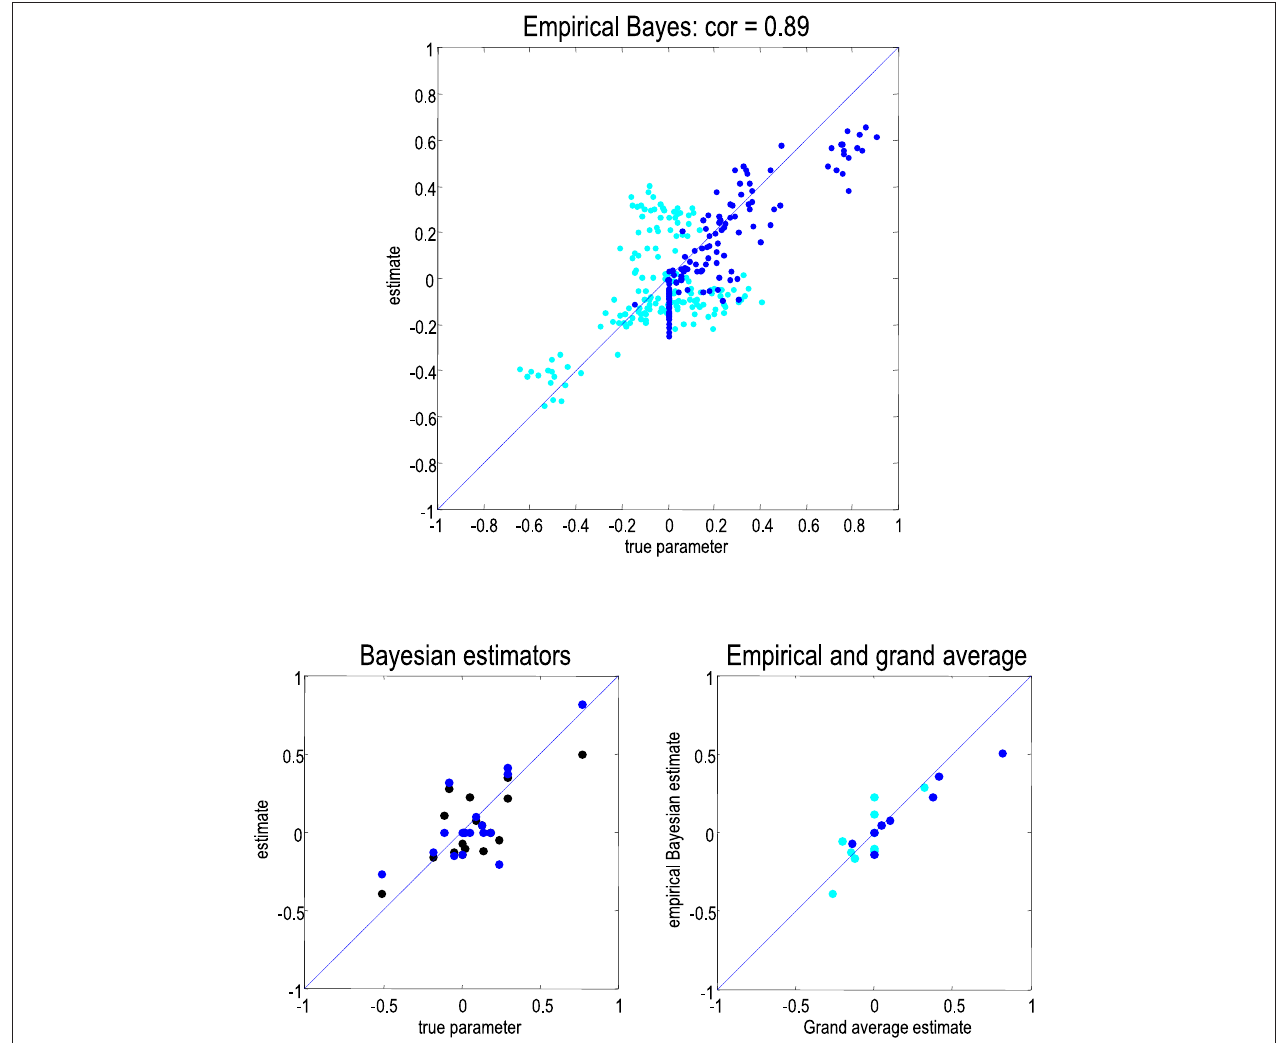
FIGURE 4 | Upper panel: A plot of the empirical Bayesian estimators of connections (cyan) and their condition-specific changes (blue) against the true values, over all subjects. The correlation coefficient corresponds to the condition-specific changes and is remarkably high. Lower left panel : this shows the posterior estimates of parameter averages from the empirical Bayesian analysis (black) and analysis of the grand mean (blue), plotted against the true group mean values. Lower right panel : this plots the two estimators against each other. As above, cyan denotes connections strengths per se , while blue corresponds to changes underlying the mismatch